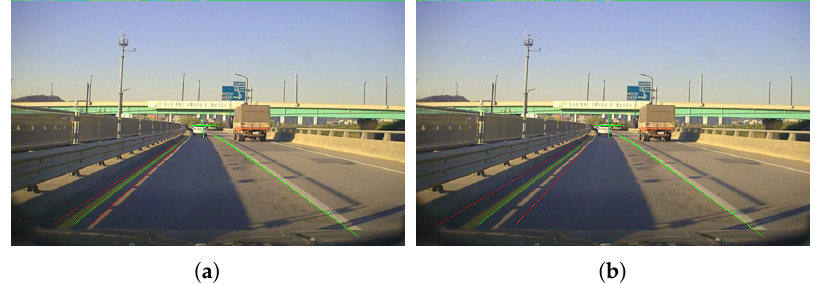
Figure 14. Examples of calculated tracking range result: ( a ) narrow tracking range result, and ( b ) normal tracking range result.